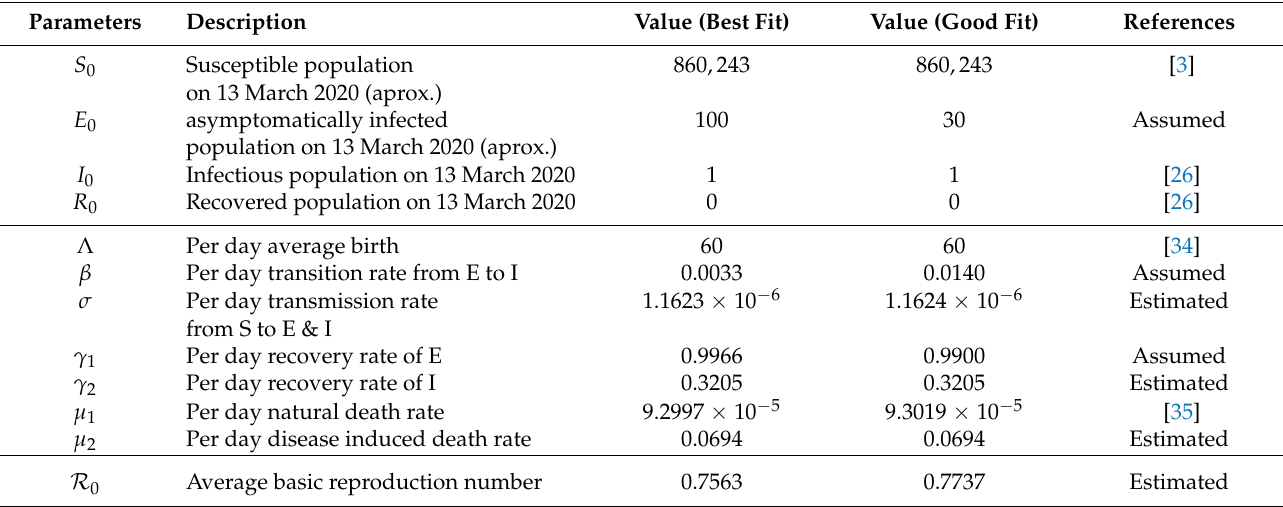
Table A2. Parameter estimations for best fitting model